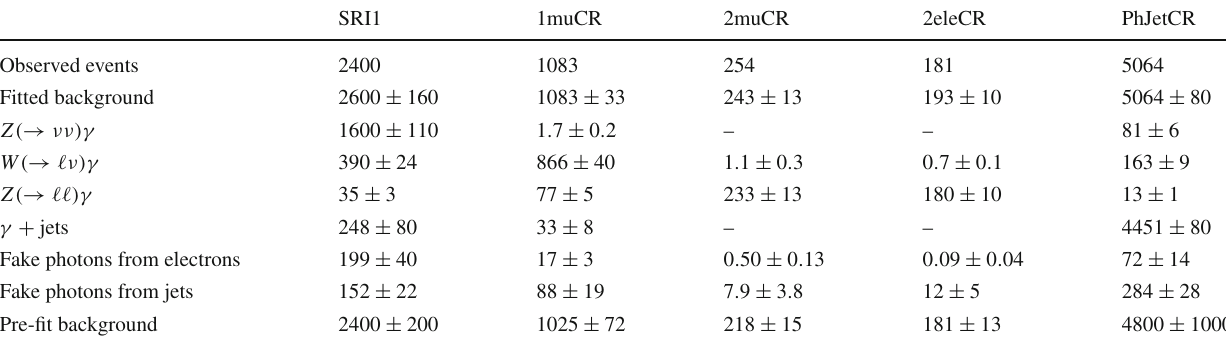
Fitted background Z ( → νν)γ